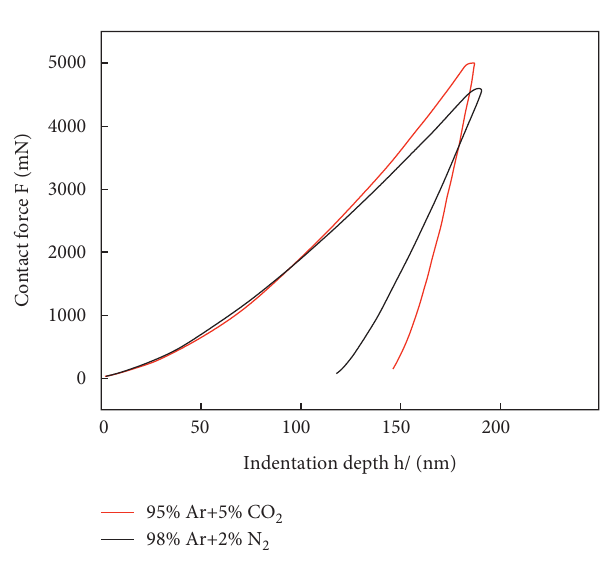
Figure 8: Load-displacement